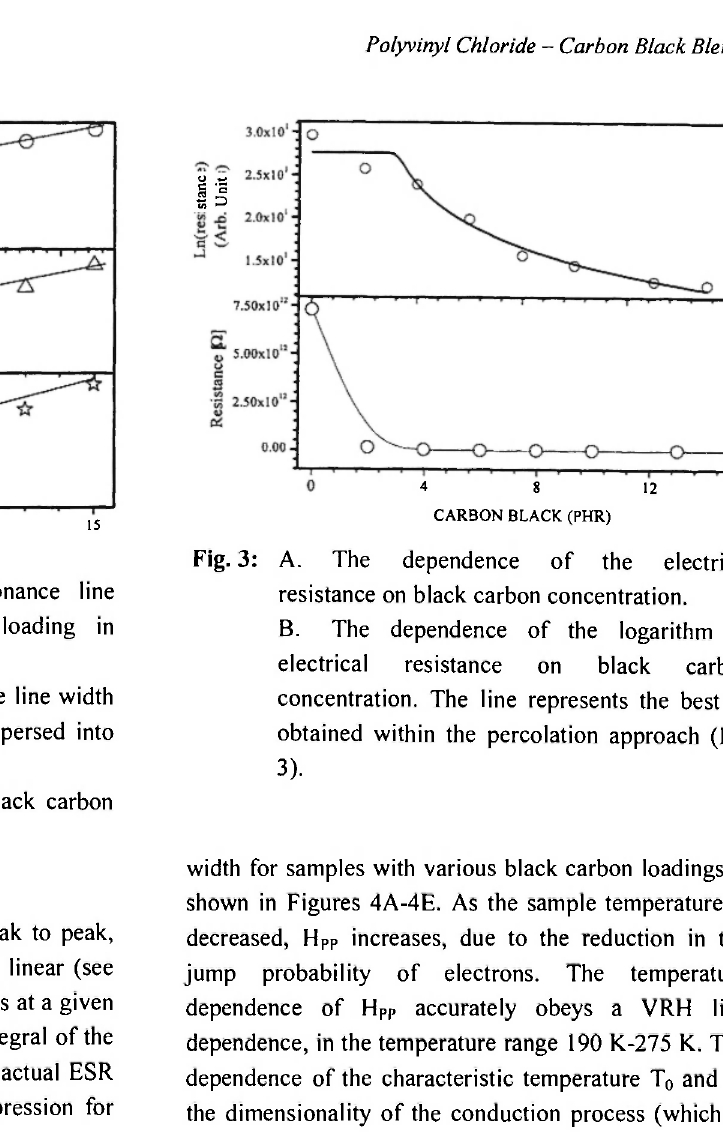
of H PP accurately obeys a VRH like dependence, in the temperature range 190 K-275 K.